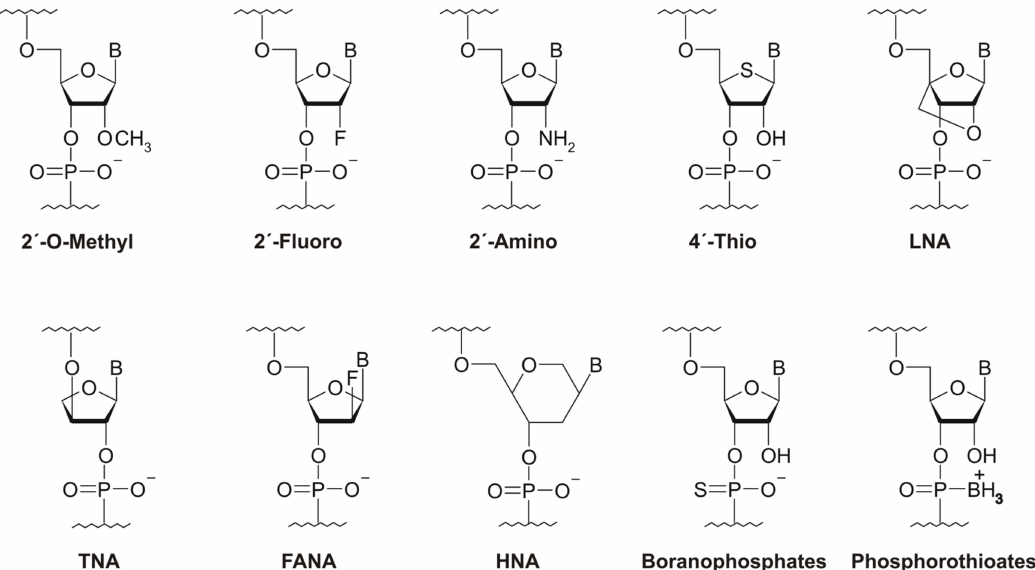
Figure 2. Sugar-phosphate backbone modifications compatible with a SELEX procedure. LNA: locked nucleic acids; TNA: threose nucleic acid; FANA: fluoroarabino nucleic acid; and HNA: 1,5-anhydro hexitol nucleic